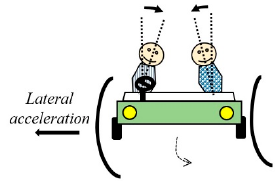
Figure 1. General head movement of the occupants.